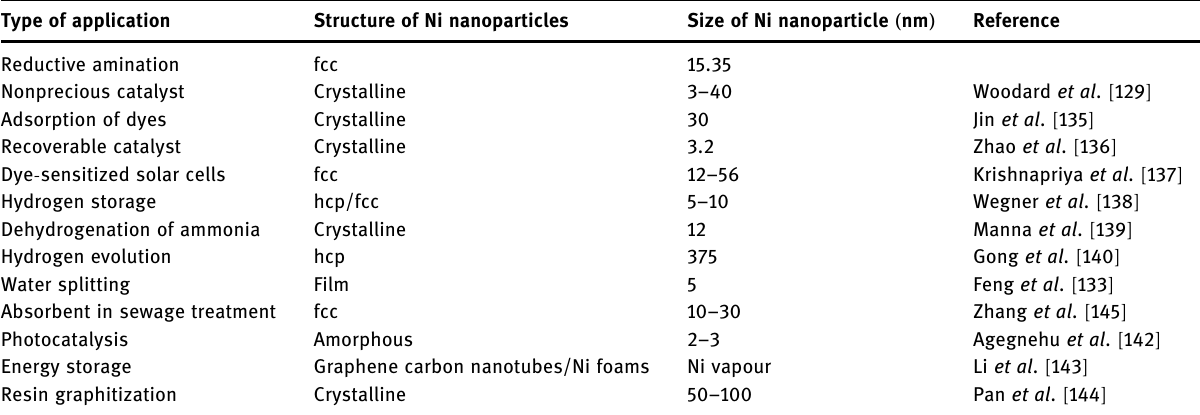
Table 6: The employment of Ni nanoparticles in catalysis Type of